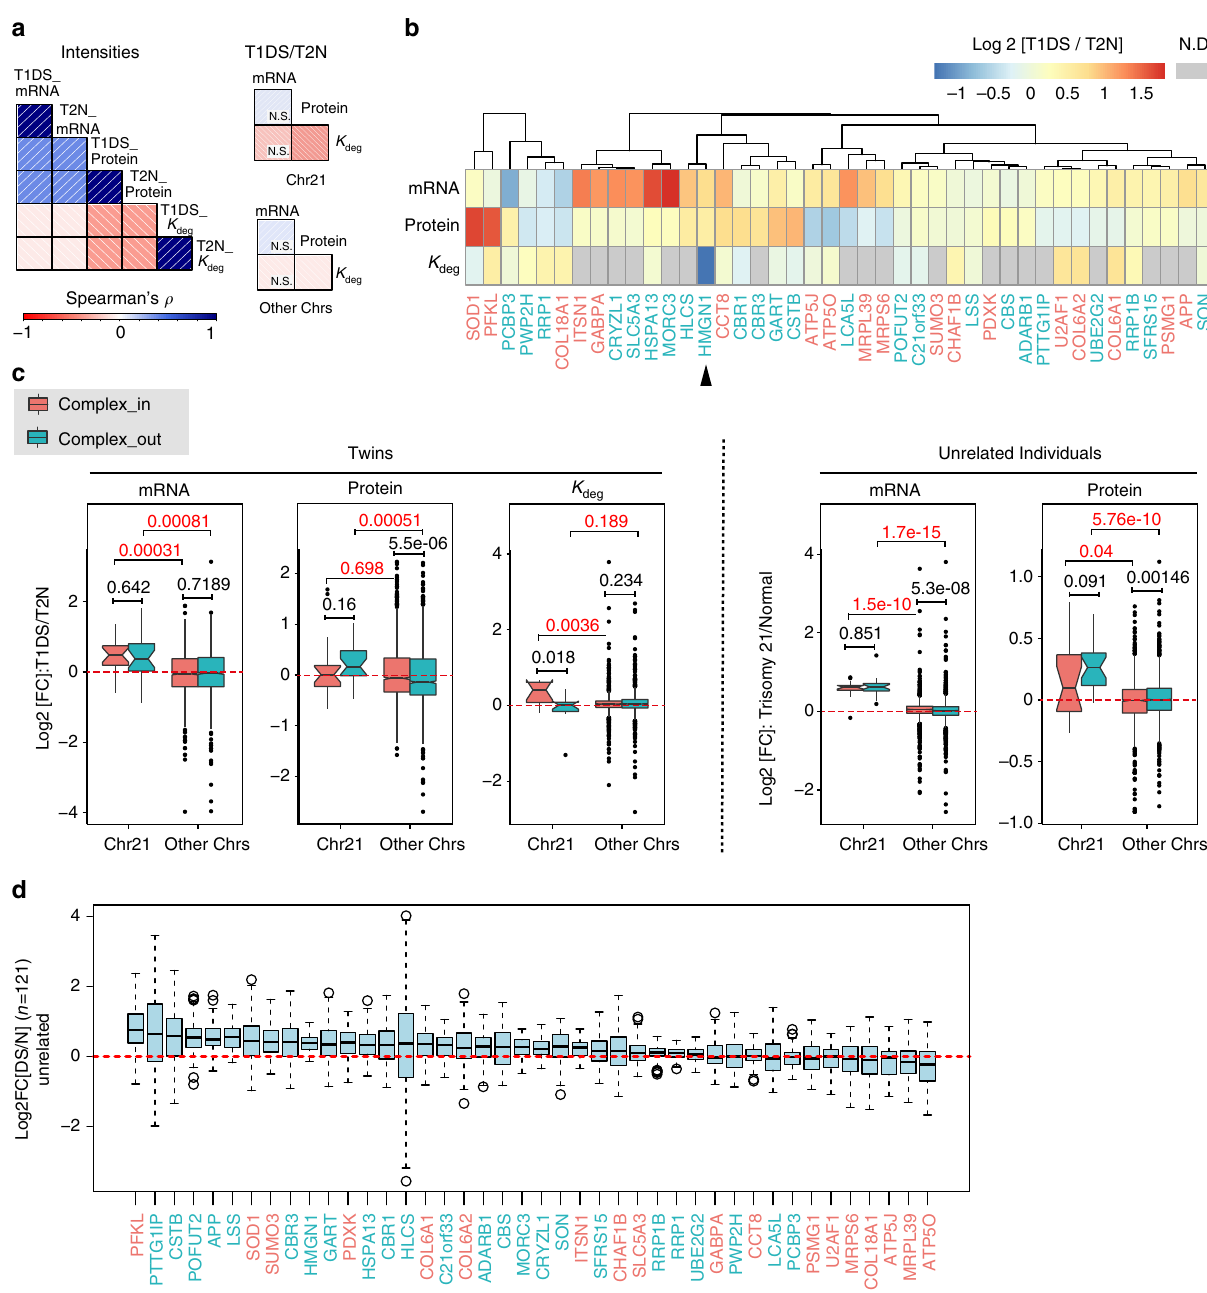
Fig. 3 Chr21 protein expression and primary dosage compensation. a Correlation analysis between absolute and relative changes between mRNA, protein, K fi cant. b Hierarchically clustered heatmap of FC for mRNA, deg for global proteome, proteins encoded by Chr21 and other chromosomes. N.S., not signi protein, and K deg . The red and green colors represent “ complex_in ” and “ complex_out ” groups, respectively. N.D., not detected. c The dosage compensation against aneuploidy through protein complex stoichiometry control remained apparent at mRNA, protein, and K deg data levels, and is con fi rmed by the samples from unrelated individuals. N = 18 and 24 for complex_in and complex_out groups from Ch21 and N = 1906 and 2068 for those from other chromosomes (Other Chrs). d Binary log2 fold changes ( N = 121 comparisons) of Chr21 protein expressions between unrelated individuals. The red and green colors represent “ complex_in ” and “ complex_out ” groups. In all box plots (Methods), the borders represent the 25th and 75th quantile, respectively, and the bold bar represents the 50th quantile. Wilcox test was used to infer P -values. Standard gene symbols are used, with corresponding SwissProt IDs listed in Supplementary Data